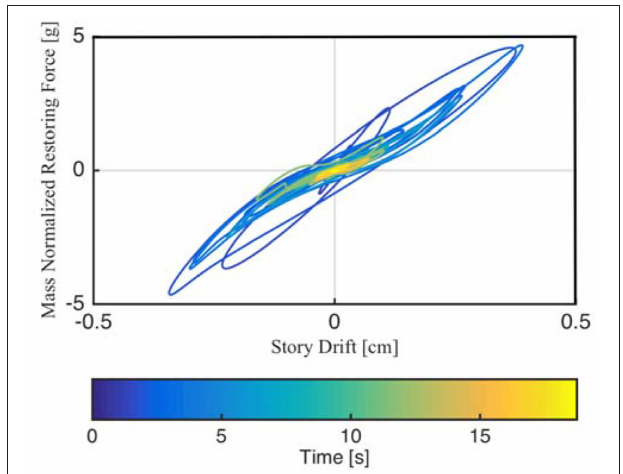
FIGURE 11 | Mass-normalized restoring force vs. story drift for specimen ES1, Run # 1.